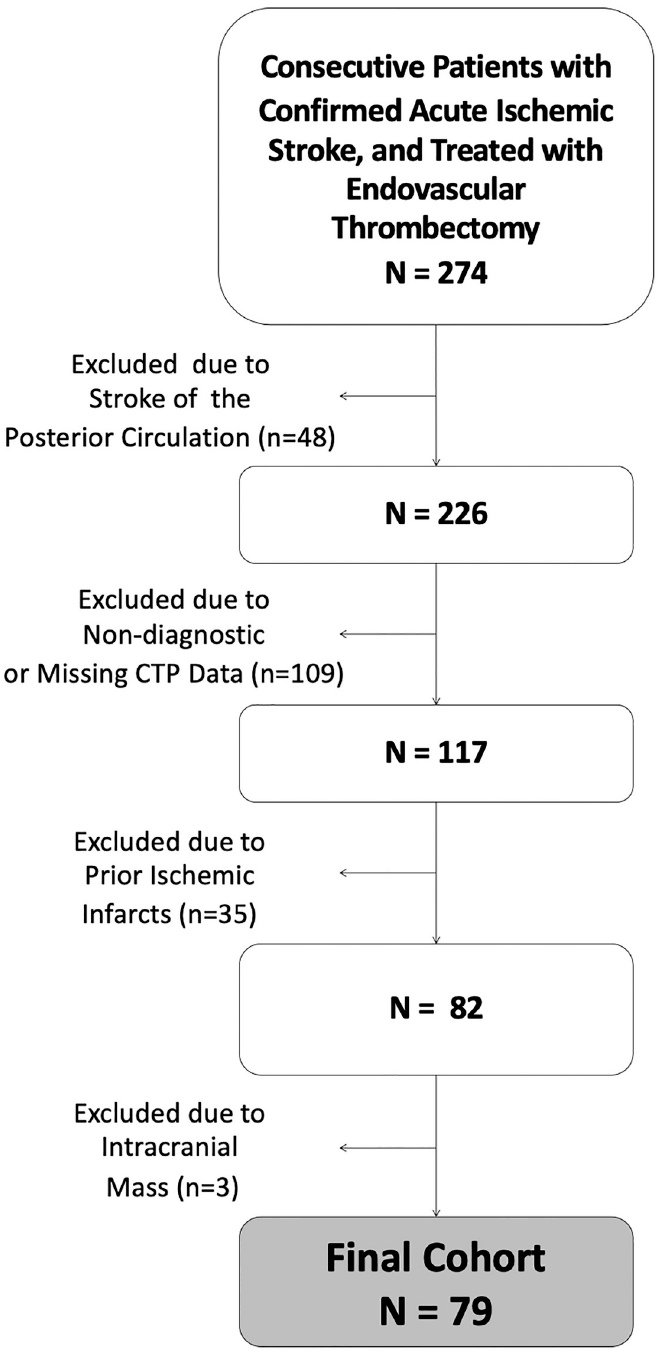
Fig 2. Flow-chart of patient selection. Abbreviations: CTP, CT